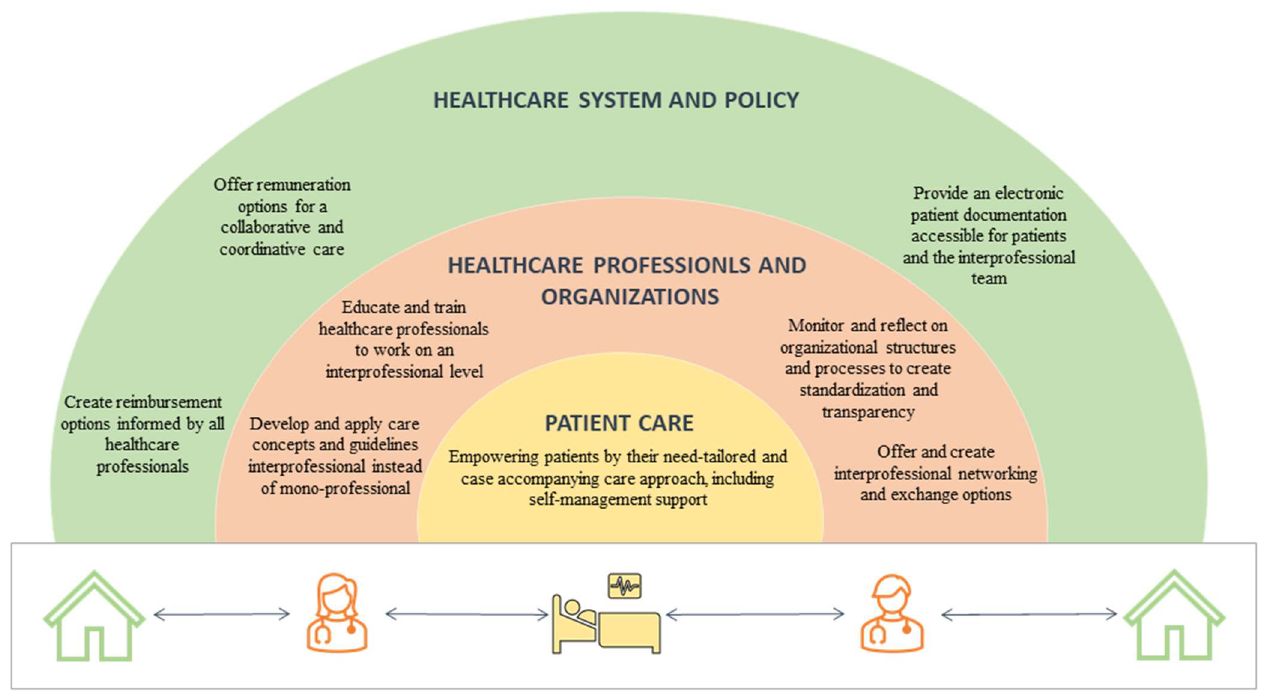
Figure 2. Systematic to foster IPC on patient, organizational and health system levels. Based on the needs of patients, the contributions of healthcare professionals and the requirements of the healthcare system are illustrated.